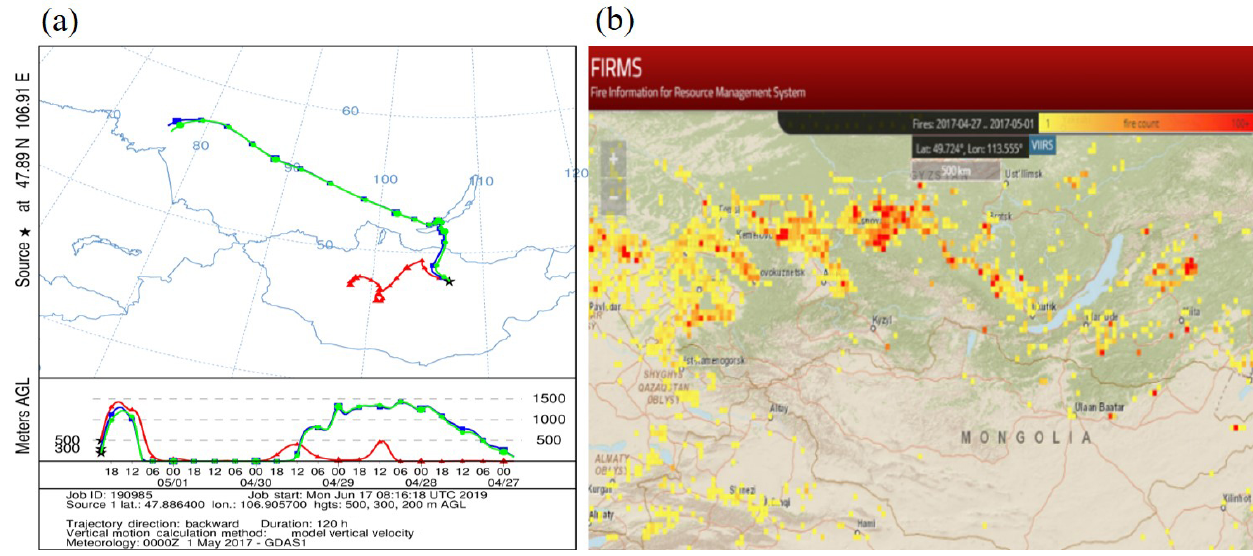
Figure 5. Conditional probability function (CPF) of levoglucosan (levo), OC, K + , EC, and Ca 2 + during winter (a) and spring (b) of 2017.